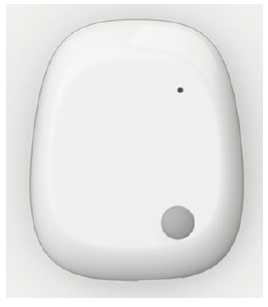
Figure 3. The Sleeve Sensor Research Kit.